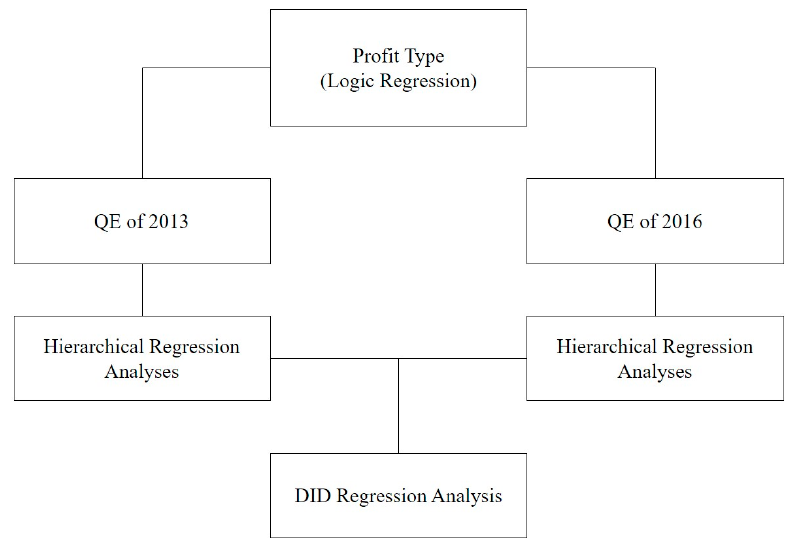
Figure 1. Research